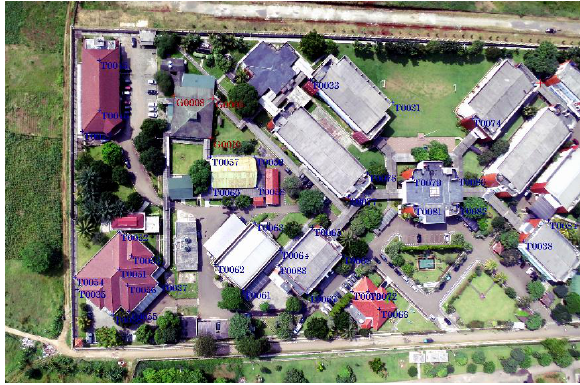
Figure 7. Simple Building Structure